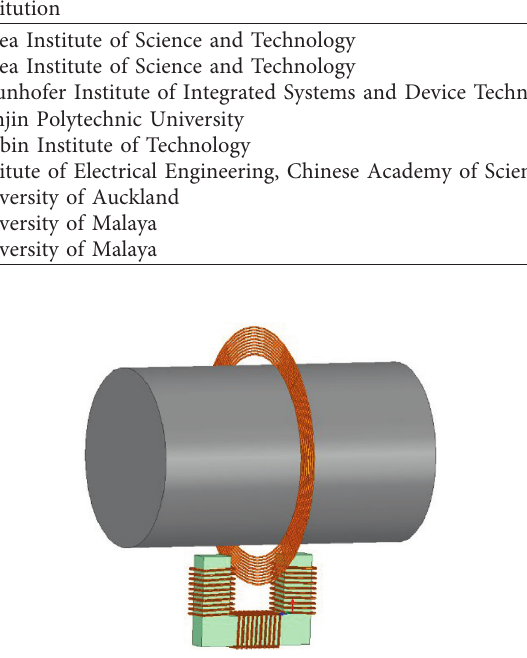
Figure 1: Schematic diagram of U-type coupling structure WPT